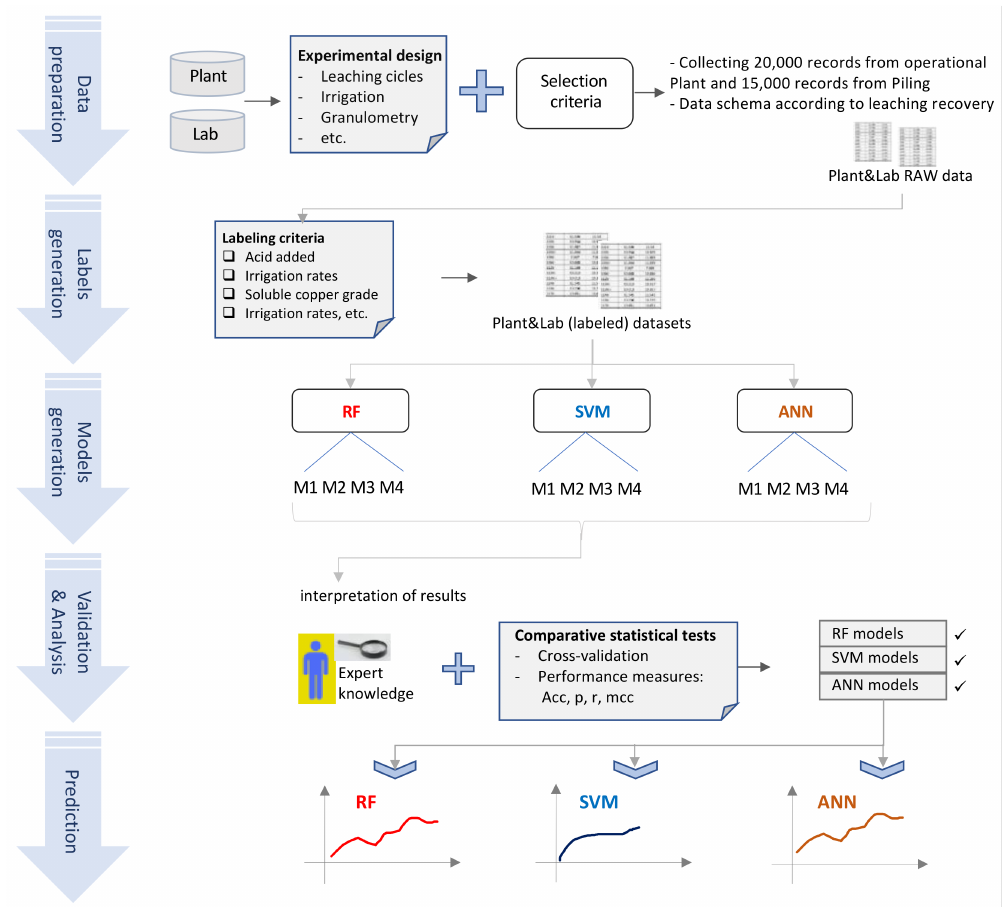
Figure 2. Workflow for copper recovery prediction using both datasets (Heap and Lab). This methodology consists of five steps, from data preparation to copper recovery prediction, using the model developed with Random Forest (RF), Support Vector Machine (SVM), and Artificial Neural Network (ANN)